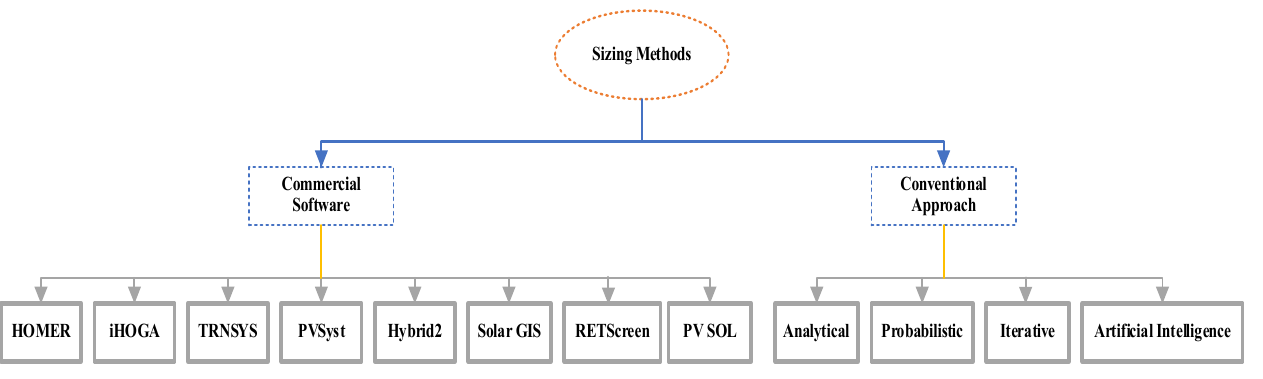
Figure 3. Methods of